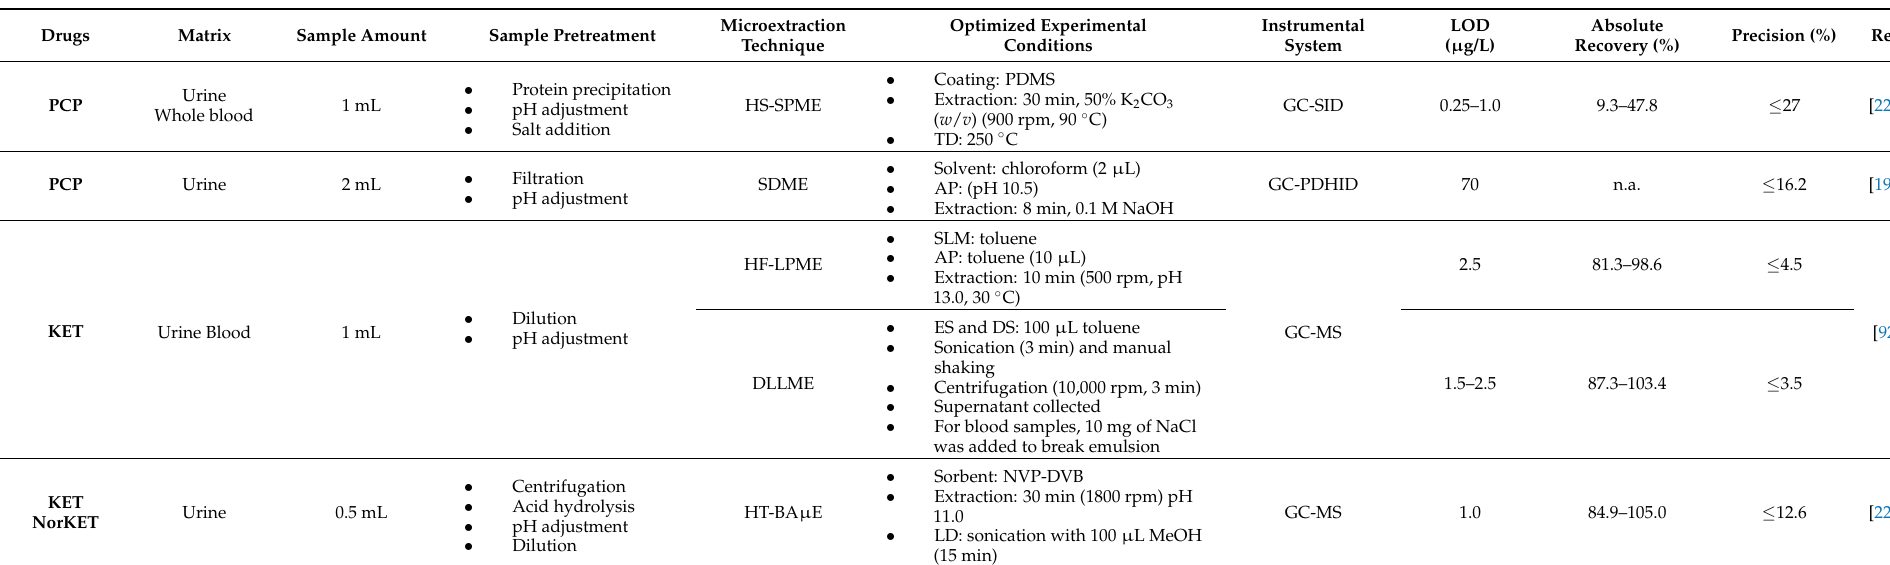
Table 6. Microextraction-based approaches for the analysis of dissociative drugs and related substances in the forensic